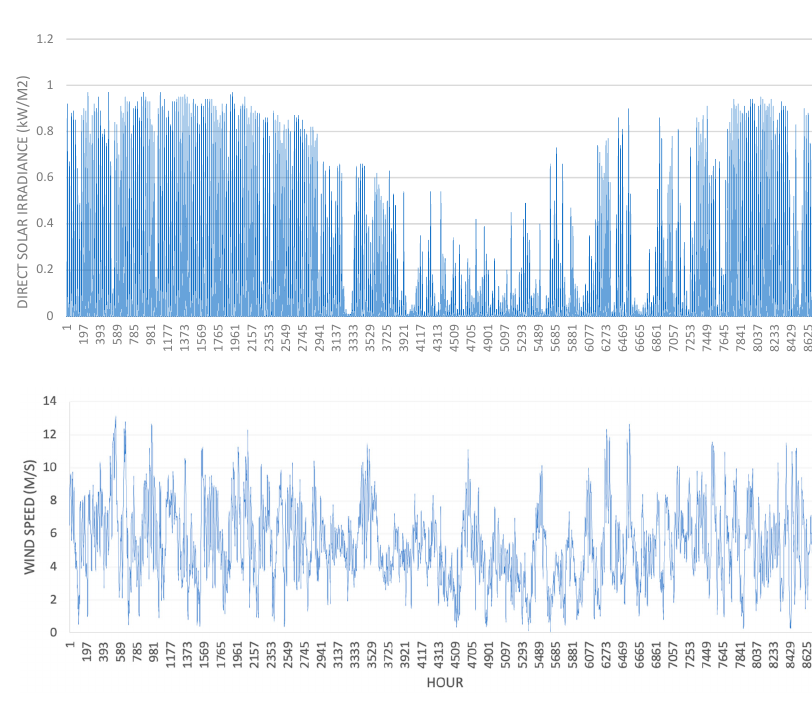
Figure 3. Load curve for sectoral electricity consumption for a weekday in January 2019 (percentage of the sectoral maximum load). Data source: [43].